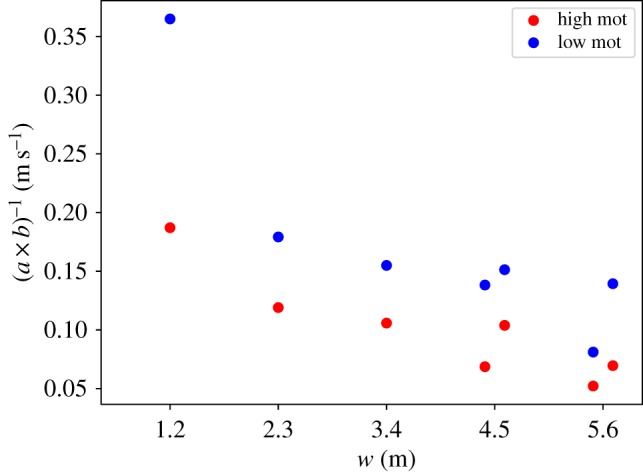
Fit parameters (a × b)−1 against corridor width.